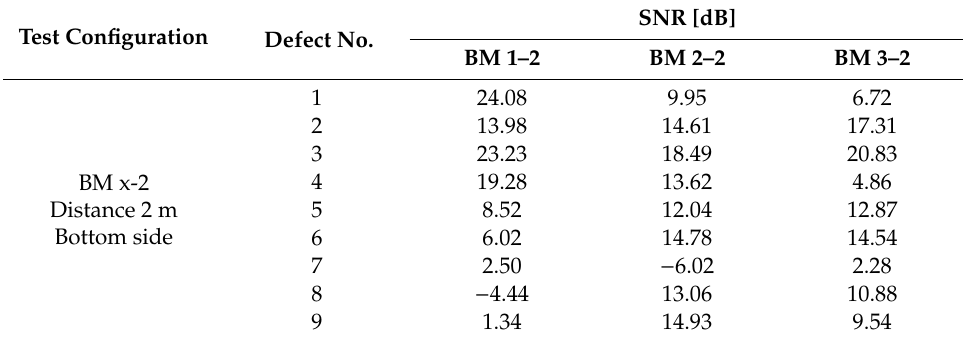
Figure 10. PCT (EOF 2 )—distance 2 m, top side: ( a ) BM 1–2; ( b ) BM 2–2; ( c ) BM 3–2. Table 5. SNR values obtained from EOFs presented in Figure 10.